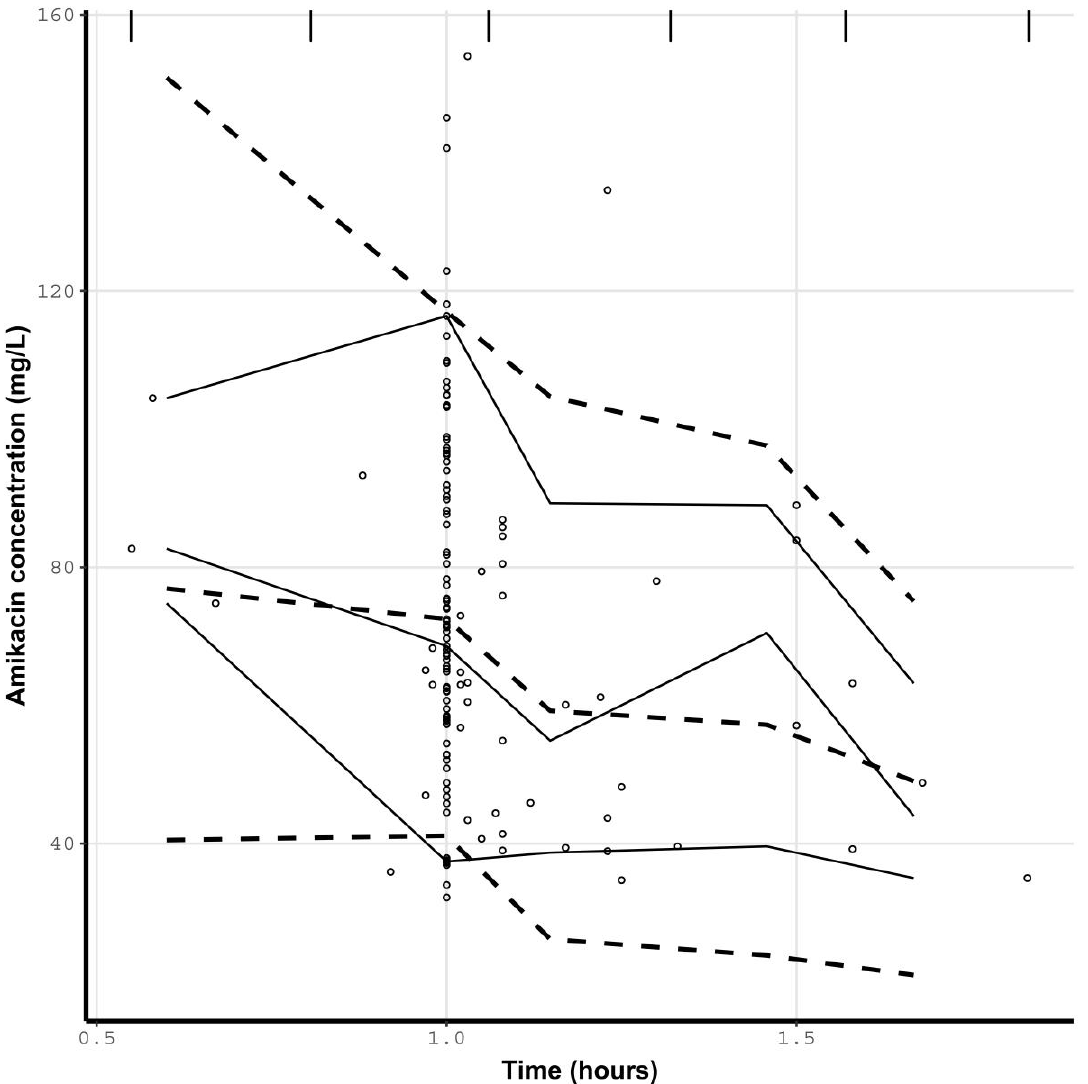
Figure 3. Visual predictive checks of amikacin concentrations against time. Open circles are observed amikacin concentrations. Solid lines represent the 5th, 50th, and 95th percentiles for observed concentrations. Dashed lines represent the 5th, 50th, and 95th percentiles for simulated concentrations. The vertical lines at the top of the plot are bin separators.